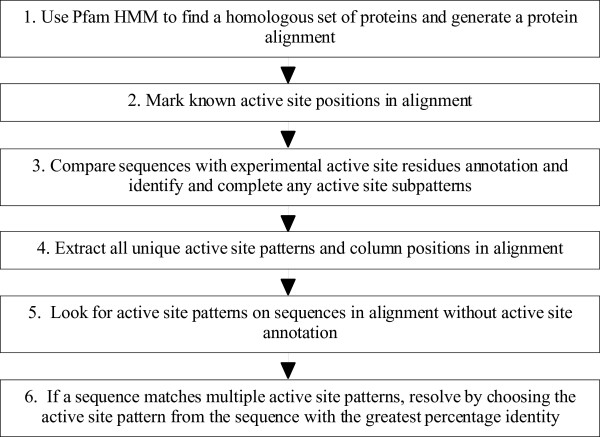
Flow diagram outlining the steps of the methodology we use to predict active site residues. Steps 1 and 2 are already present in Pfam and our methodology adds steps 3–6. See text for discussion.